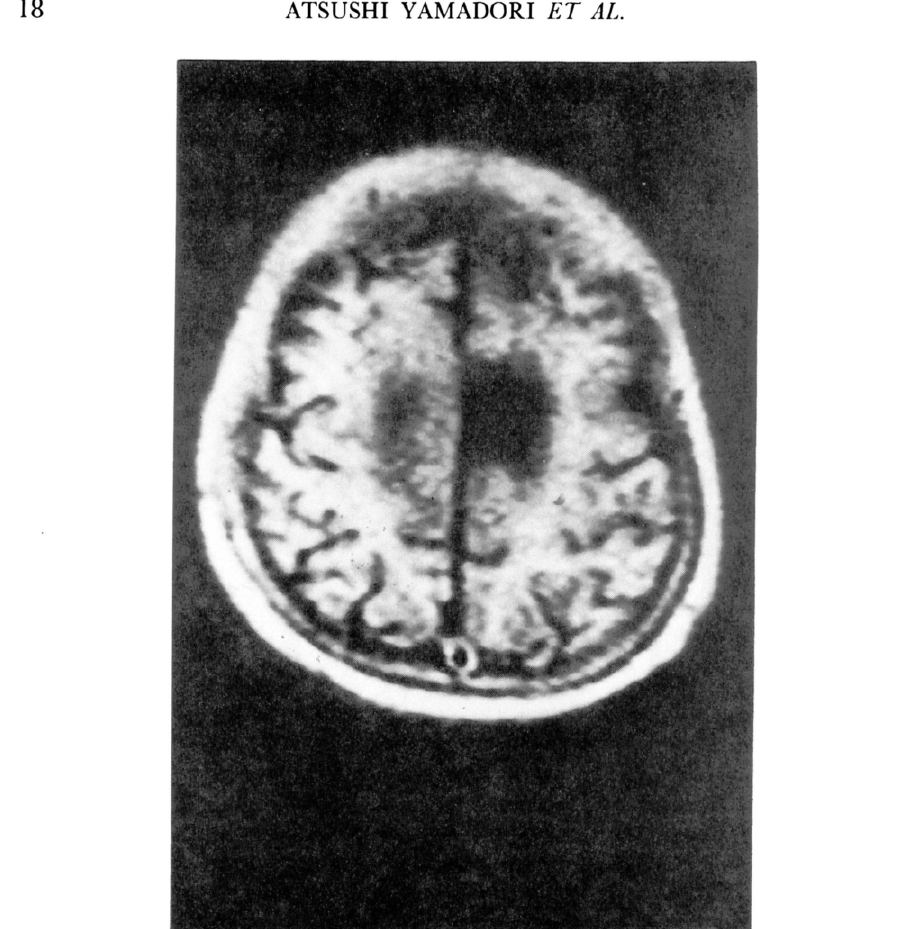
FIG. 3. Same MRI image of horizontal section at a level of the roof of the lateral